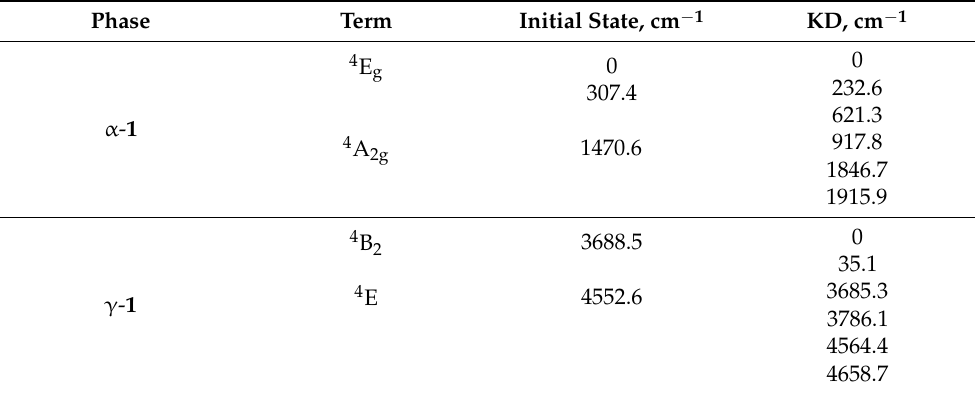
Table 5. CASSCF/NEVPT2-calculated relative energies of initial states and spin-orbit states (six lowest Kramer’s Doublets) for α - 1 and γ - 1 .